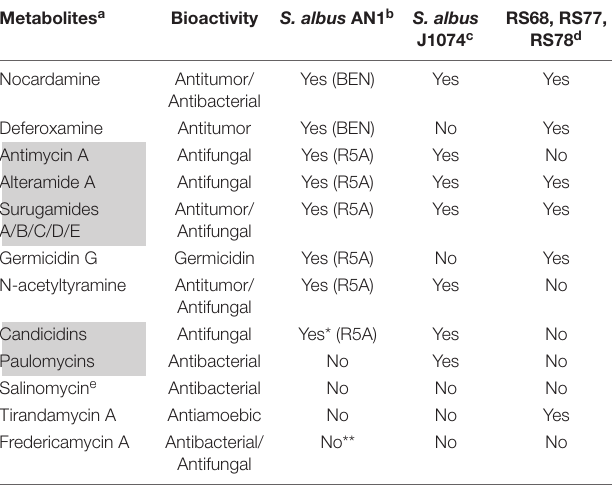
TABLE 1 | Bioactive metabolites produced by our isolate S. albus AN1 by comparison with reference laboratory strain S. albus J1074 and other S. albus (-like)